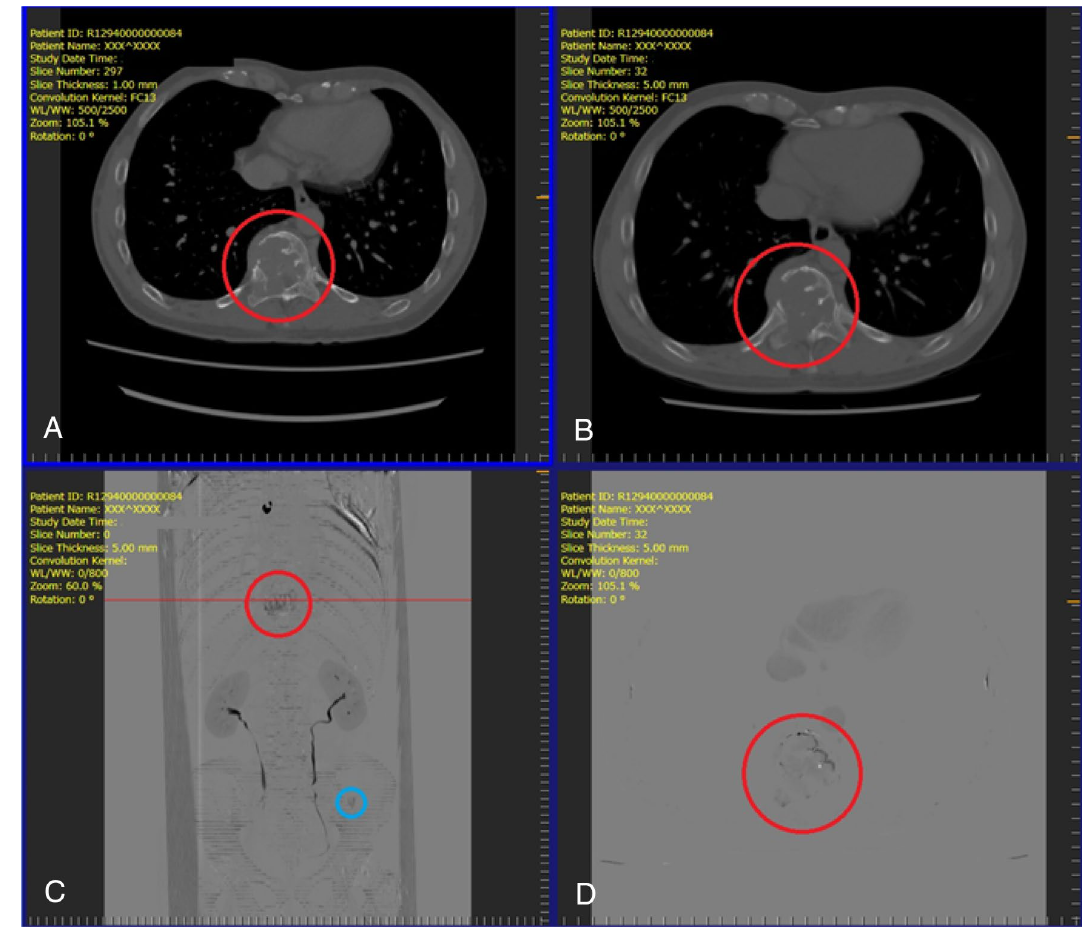
Figure 2. Screenshot of the image viewer for the observer study. ( A ) previous computed tomography (CT) image (upper left); ( B ) current CT image (upper right); ( C ) projection of temporal subtraction (TS) images (lower left); ( D ) TS image (lower right). When an observer clicks on a suspicious lesion, the dialog box appears to rate its likelihood (low to high) of being a bone metastasis. These representative images are obtained from a 55-year-old male patient with renal cell carcinoma who developed two osteolytic metastases in a thoracic vertebra (red circle) and the left iliac bone (blue circle). Both metastases are clearly